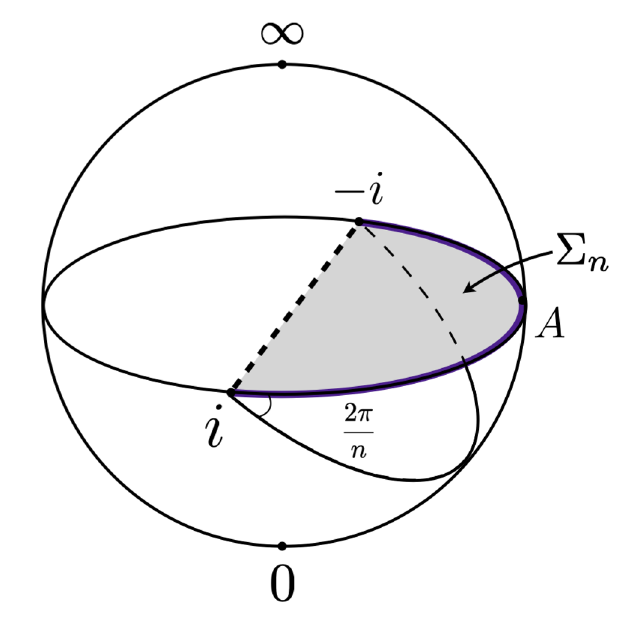
Figure 2 . The conical singularity geometry M n and entanglement wedge region Σ n corresponding to the boundary region A . The thick striped line corresponds to the cosmic brane extending from − i to i . The backreaction process creates a conical singularity of opening angle 2 π/n